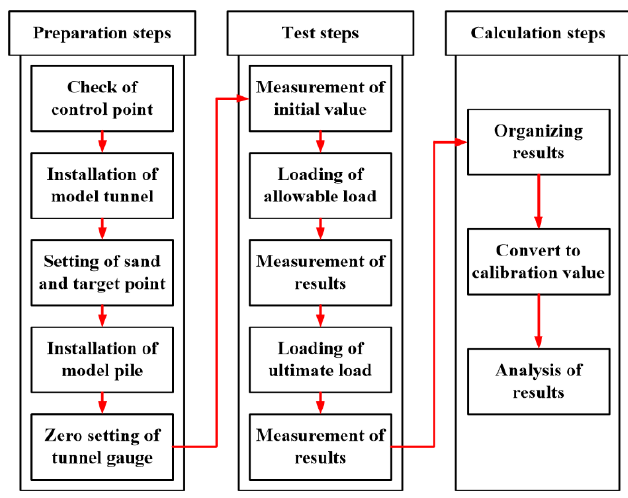
Figure 12. Procedures in model test.